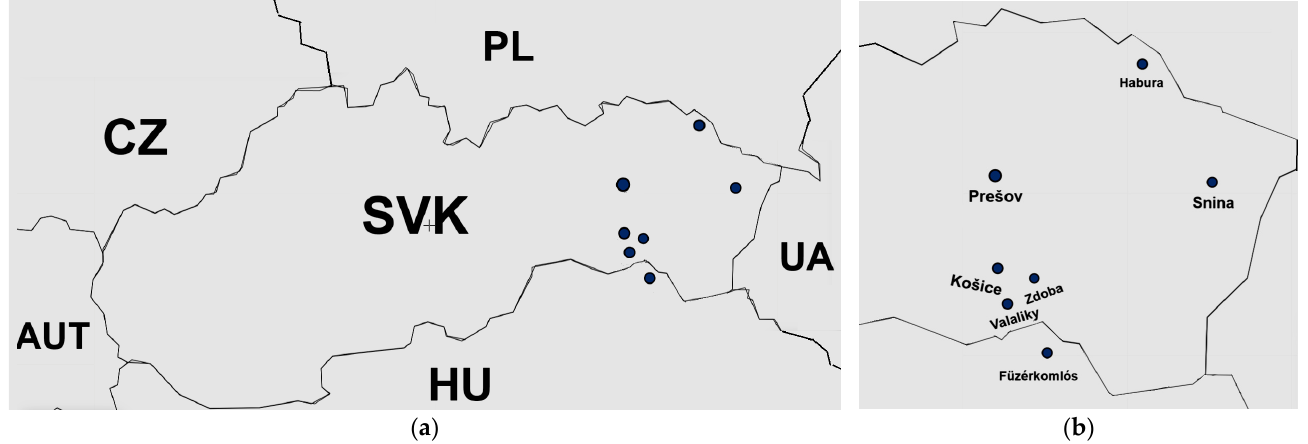
Figure 5. Urban and rural measurement places marked on a map of: ( a ) Slovakia; ( b ) eastern Slovakia (close-up).